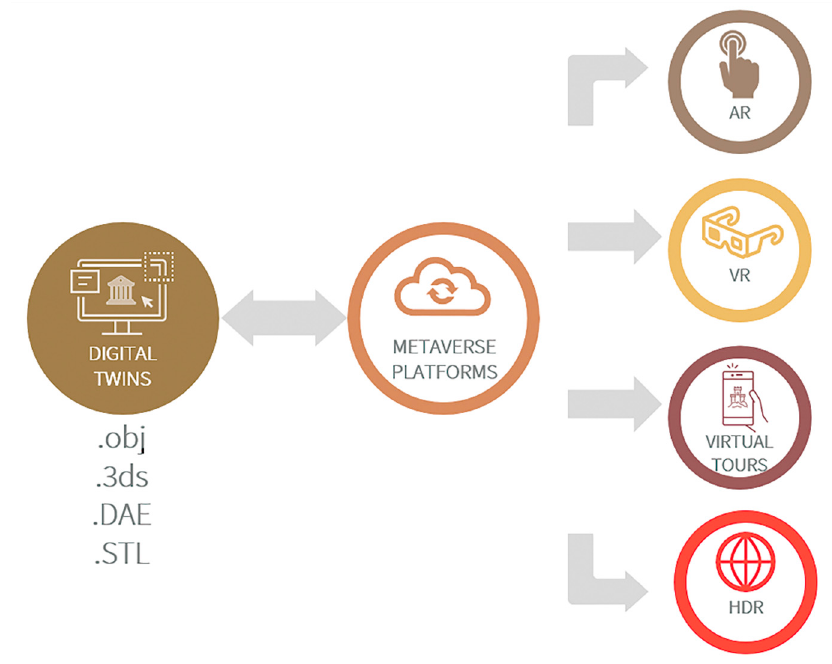
Figure 2. Workflow based on publishing digital twins on different digital platforms.